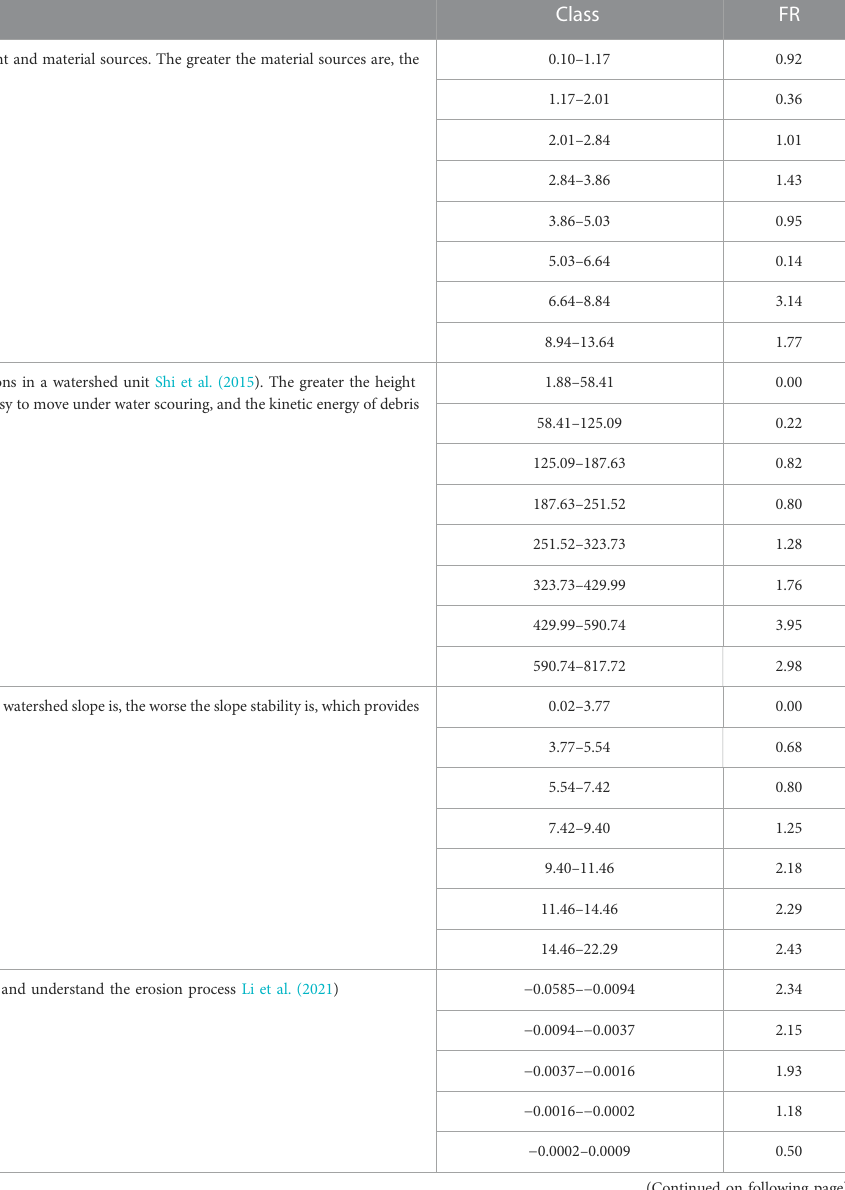
The relative elevation difference is the value between the highest and lowest elevations in a watershed unit Shi et al. (2015). The greater the height difference is, the greater the potential energy of the debris fl ow is, loose deposits are easy to move under water scouring, and the kinetic energy of debris